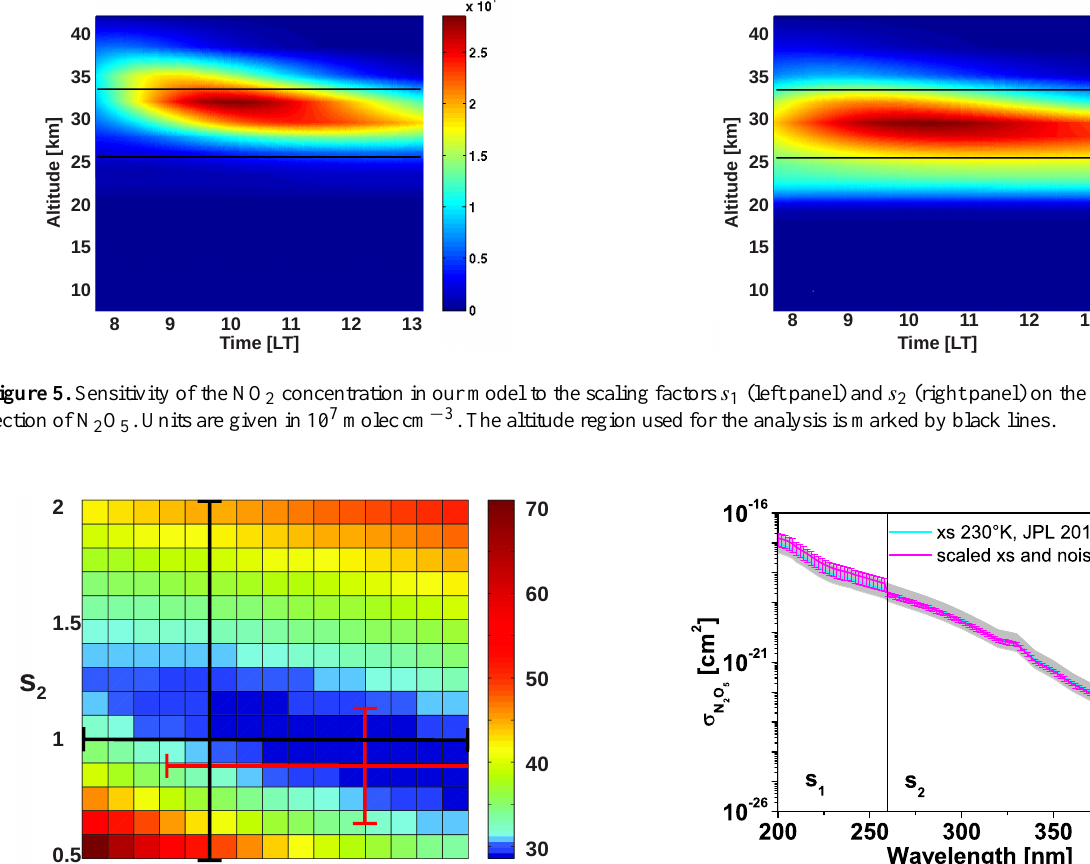
(λ,T ) measured in the laboratory (JPL-2011, Figure 7. σ N 2 O 5 shown in light blue) and inferred in the present study (shown in Fig. 7. σ N 2 O 5 ( λ,T ) measured in the laboratory (JPL-2011, shown in light blue) and inferred in the present study (shown in pink). Figure 6. χ 2 as a function of s 1 and s 2 , as given in Eq. (9). The inferred global minimum is shown in red together with the total error due to noise error of the retrieval. The corresponding JPL- 2011 values are given in black.